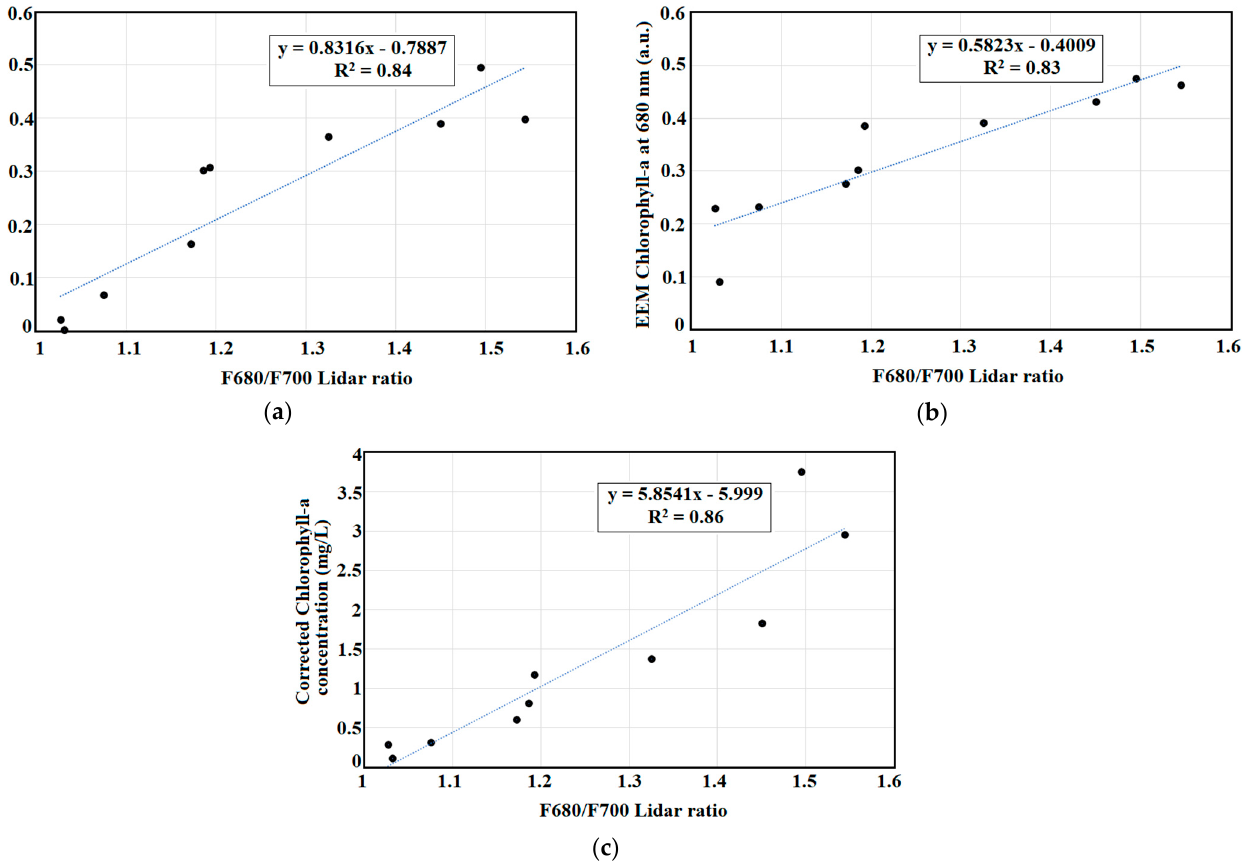
Figure 9. Scatter plot of Spirulina concentration and F680/F700 lidar ratio. F680/F700 provides a measurement of chlorophyll-a concentration by incorporating turbidity measurements in understanding algal growth monitoring. This lidar ratio was correlated with absorbance at 680 nm (R 2 = 0.84), EEM chlorophyll pigment at 680 nm (R 2 = 0.83), and corrected chlorophyll-a pigment (R 2 = 0.86) as shown in Figure 10.